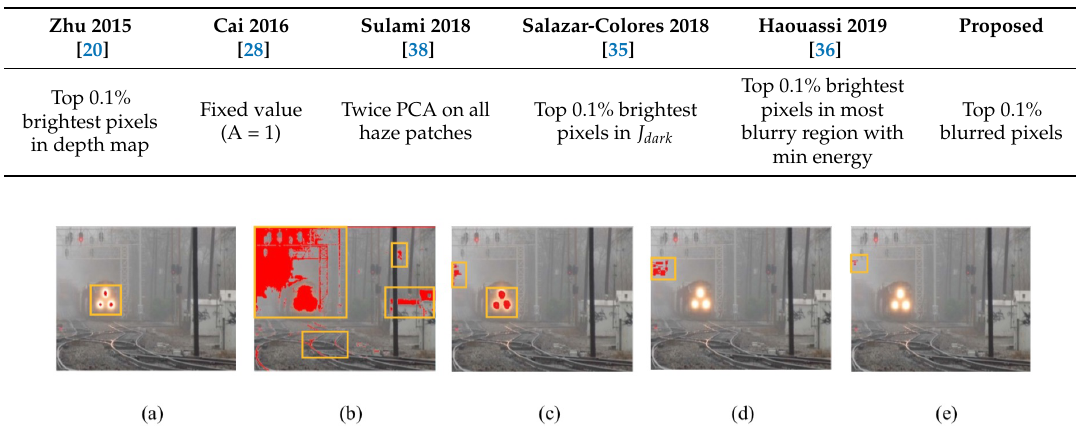
Figure 5. Parts of interest for estimating AL in different existing dehazing methods and the proposed one: ( a ) Zhu’s method [20]; ( b ) Sulami’s method [38]; ( c ) Salazar-Colores’s method [35]; ( d ) Haouassi’s method [36]; and ( e ) the proposed